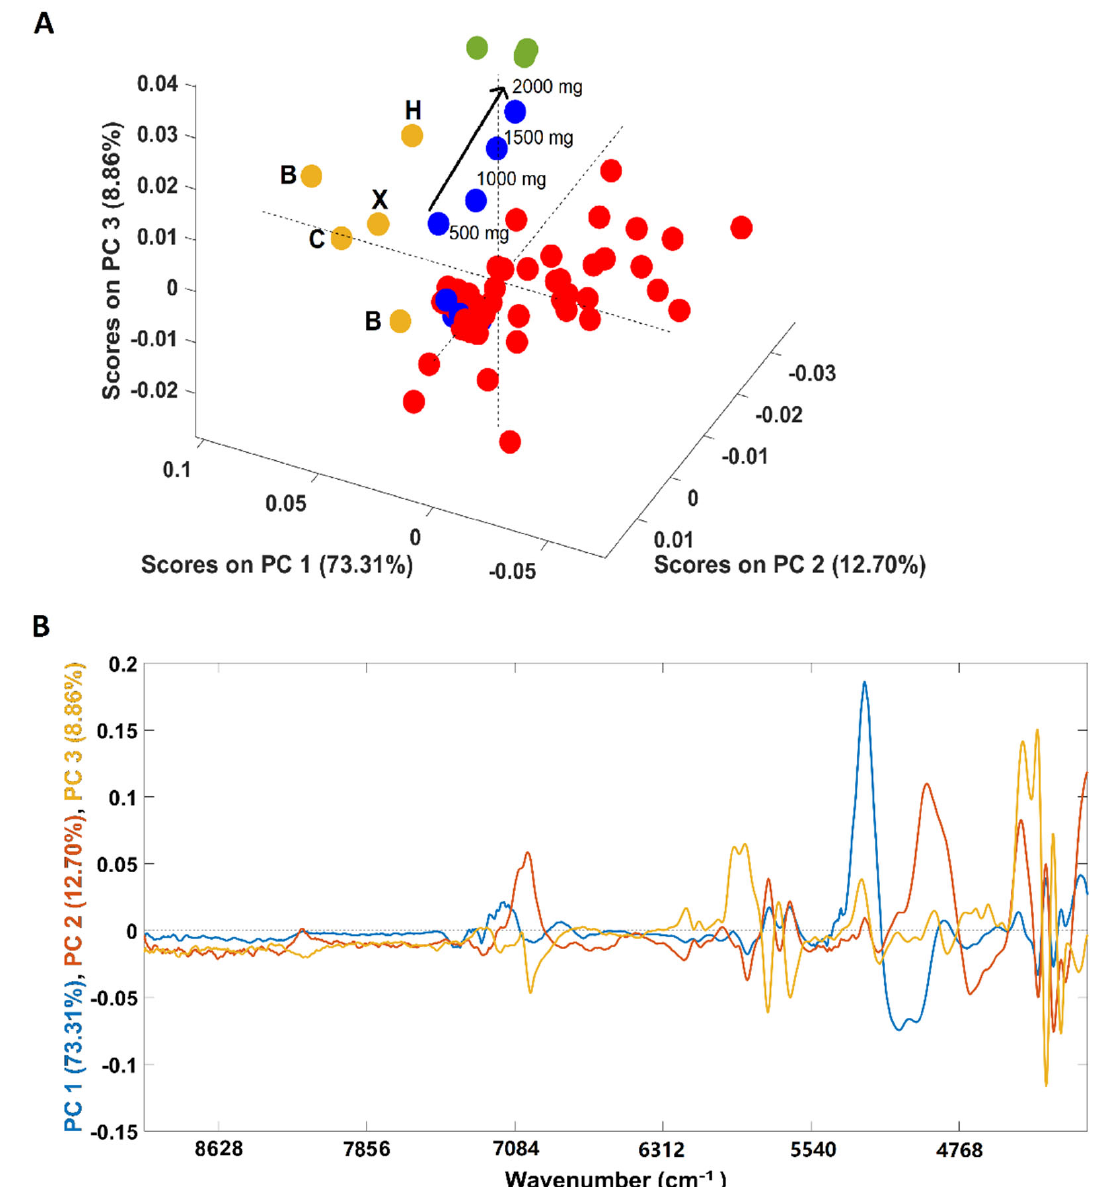
Figure 2. Scores plot of the PCA models developed solely with samples containing coffee ( A ) and its corresponding loadings ( B ). Legend: • arabica (B = Brazil, H = Honduras, C = Colombia, X = blend of the 4 arabica samples); • robusta; • adulterated samples with robusta; • adulterated samples with rice/corn/soy/barley/coffee husks.